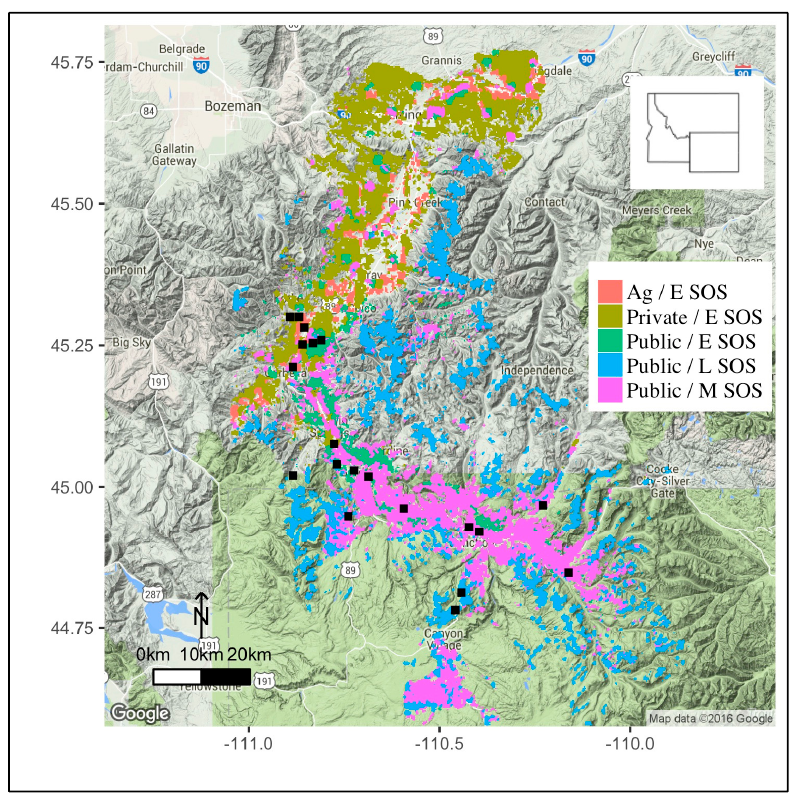
Figure 1. Map of grasslands in the start of season (SOS) classes (early, mid, late SOS classes) and land use classes (irrigated agriculture, private grasslands, and public grasslands) in the Upper Yellowstone River Basin (UYRB). Irrigated agriculture and private grasslands were only present in the low-elevation grasslands with early onset of growth (early SOS). Squares represent the 20 pixels sampled in this study.